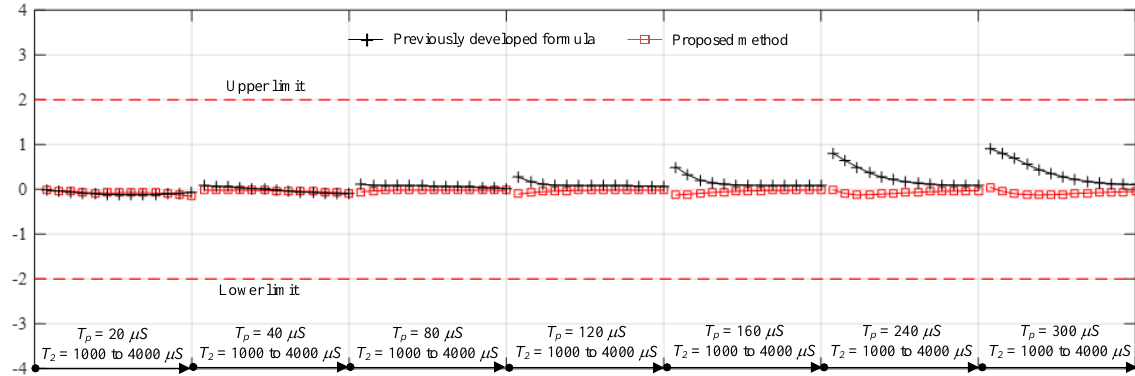
Figure 7. Comparisons of the computed T 2 by the proposed and previously developed formulas [16] and the standard tolerance [10].